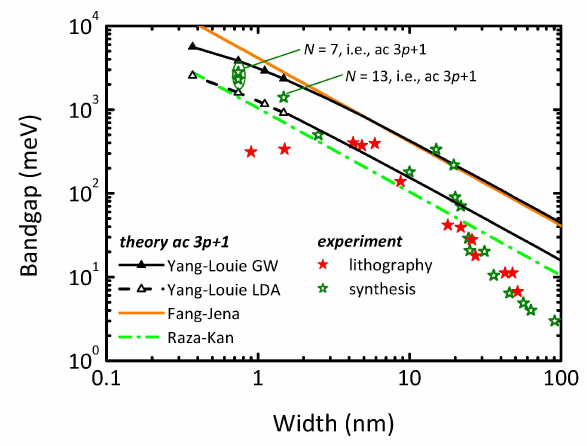
Figure 1. Measured and calculated bandgap of ac GNRs (graphene nanoribbon) vs. ribbon width. The experimental data for the N = 7 and N = 13 ac GNRs are taken from [10,32,33] and the other experimental data are taken from the compilation in [31]. The calculated bandgaps are taken from